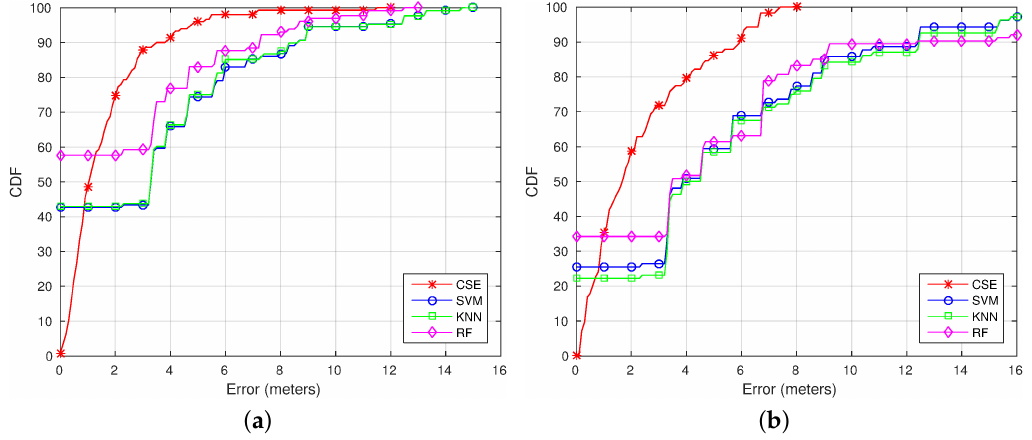
Figure 10. CDF using the trajectories dataset. ( a ) Trajectory 1; ( b ) Trajectory